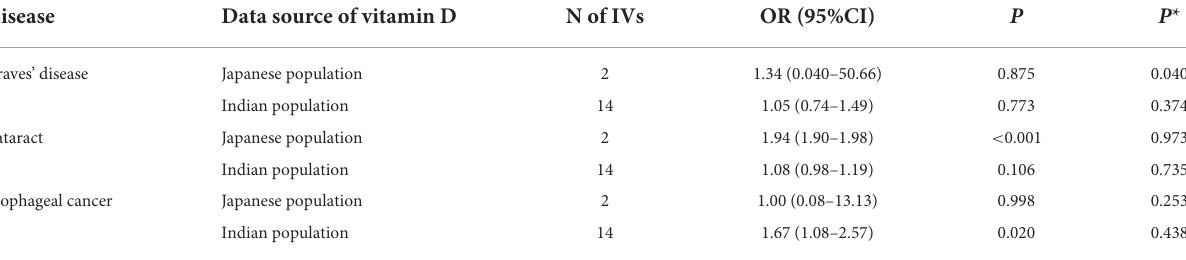
Esophageal cancer